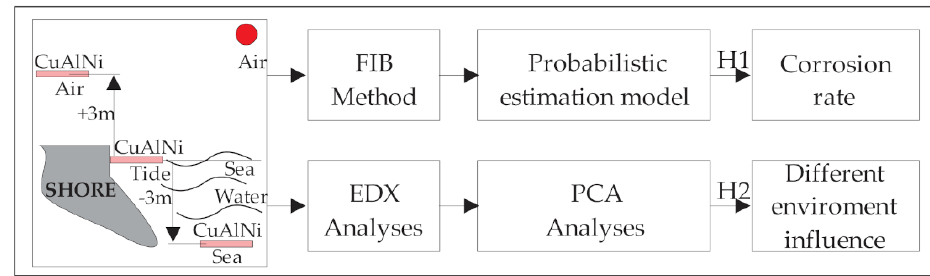
Figure 4. The scheme of the conceptual model of the research for CuAlNi